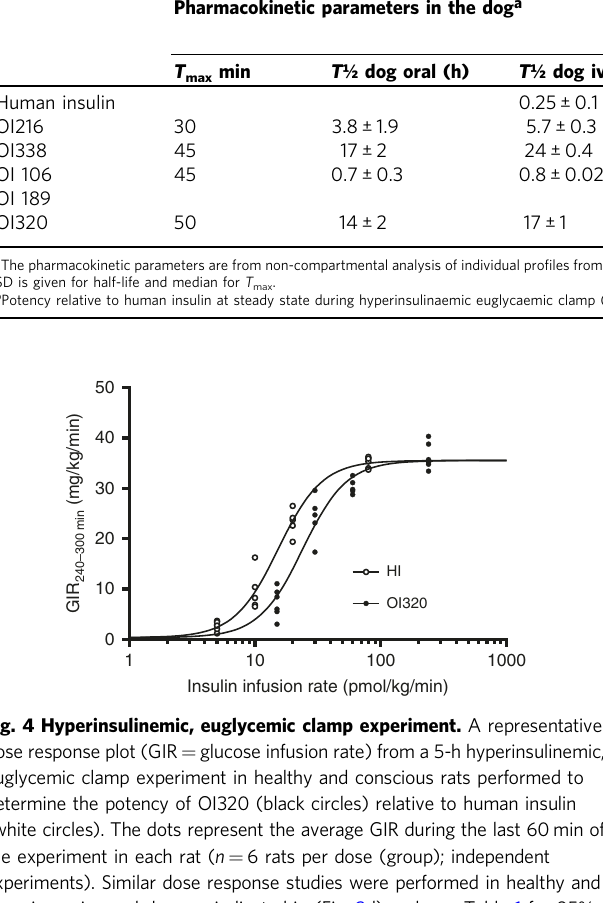
Table 1 Pharmacokinetic and pharmacodynamic parameters of insulin analogues in animals. Pharmacokinetic parameters in the dog a